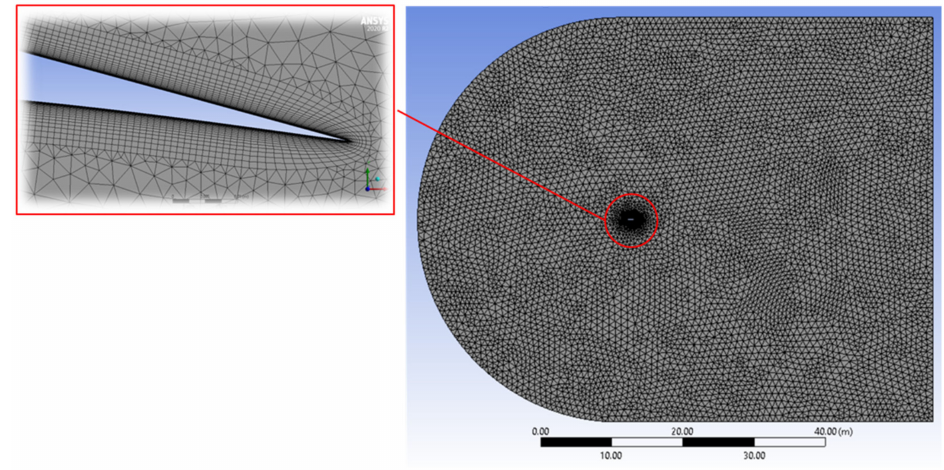
Figure 2. Domain mesh with zoom-in on the trailing edge.